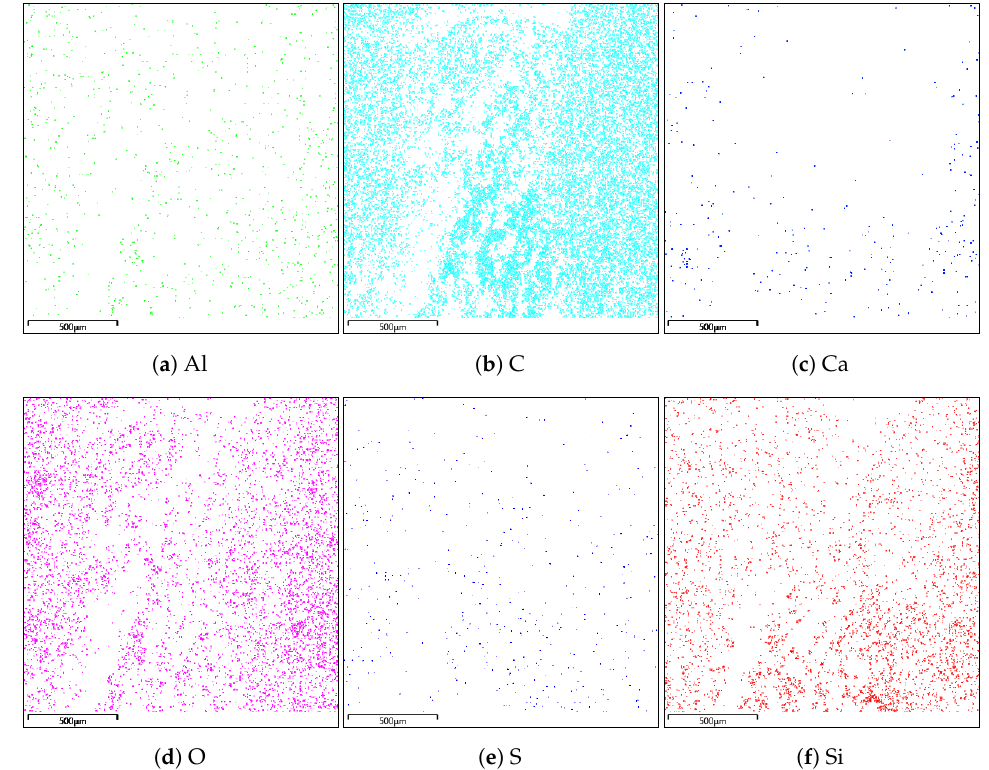
Figure 14. Distribution of individual chemical elements on the cross-sectional area in the material M2.